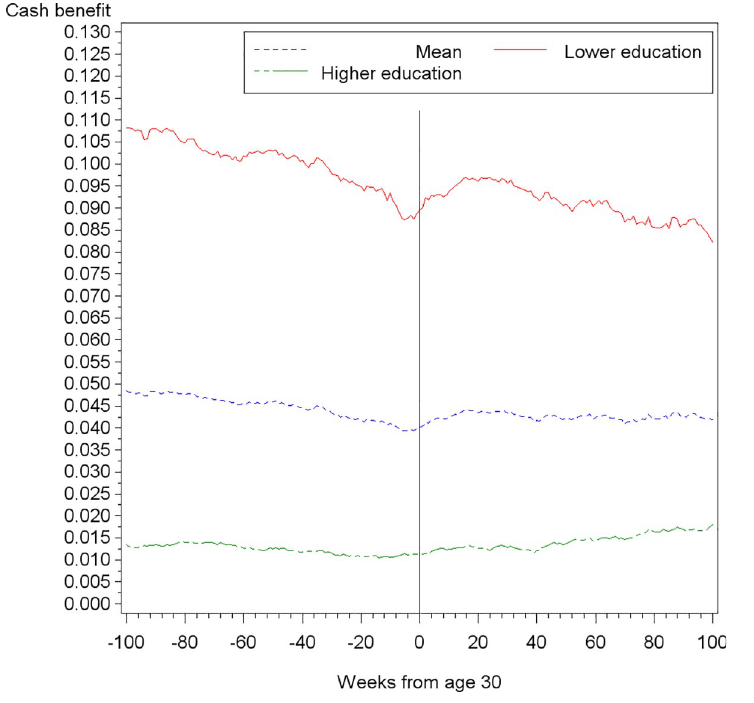
Fig 1. Mean share of cash benefit recipients by education